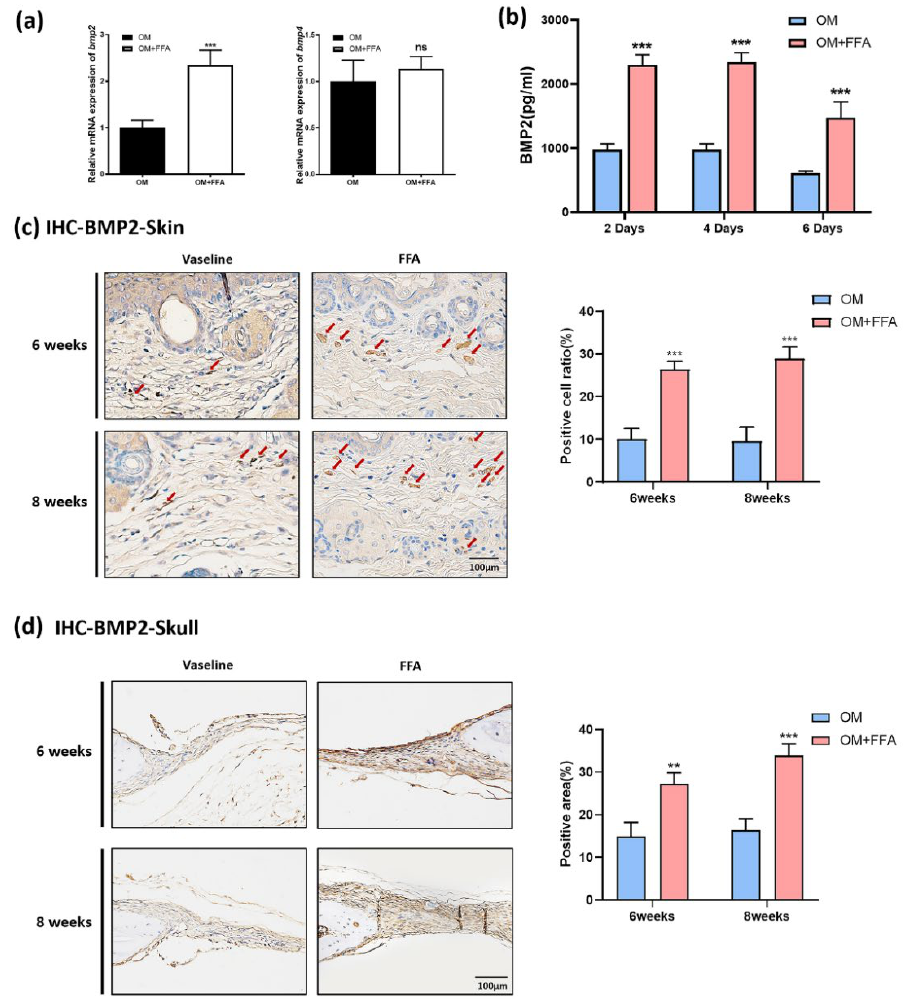
Figure 4. Butyl flufenamate ointment accelerated cranial-defect healing in mice by promoting BMP2 secretion in mSMSCs. ( a ) qRT-PCR showing that FFA increased the mRNA expression of bmp2 but not bmp4 in mSMSCs. ( b ) ELISA showing that FFA increased BMP2 secretion in mSMSCs at days 2, 4, and 6. ( c ) IHC staining of BMP2 in the skin in the cranial-defect area in different groups and the percentage of positively stained cells calculated according to the IHC images. Scale bar = 100 μm. ( d ) IHC staining of BMP2 in the cranial-defect area in different groups and the percentage of the positive staining area calculated according to the IHC images. Scale bar = 200 μm. ** p < 0.01, *** p < 0.001, ns no significance.